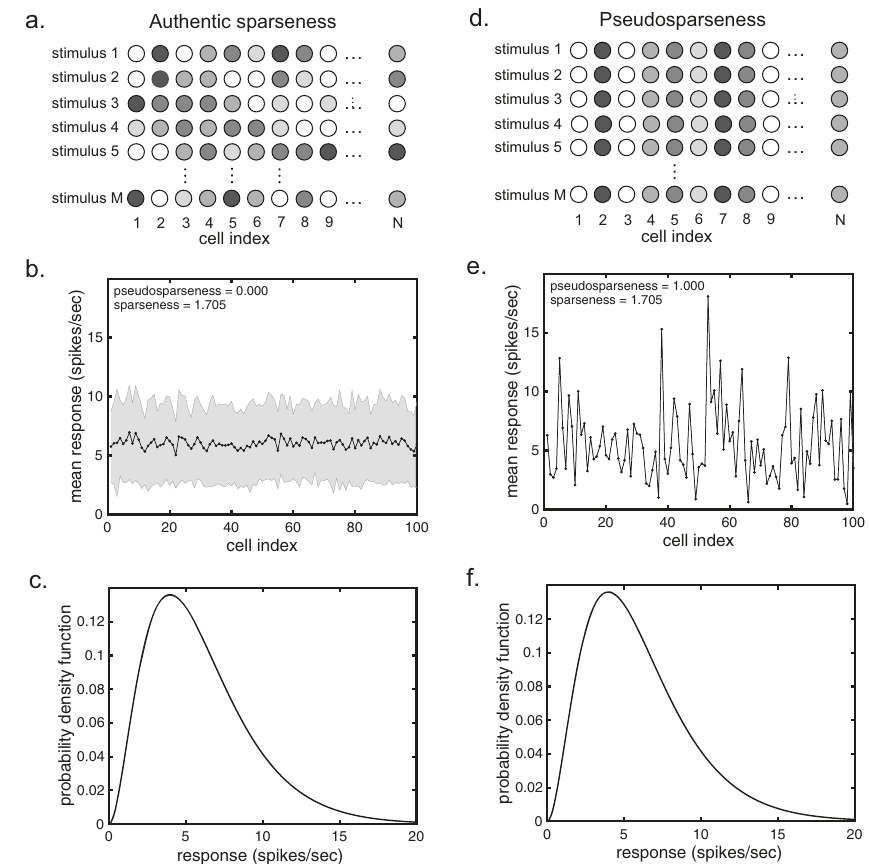
Fig. 1 Comparison between sparseness and pseudosparseness. a – c Example showing authentic sparseness. a Responses of the same neural population to different stimuli, under authentic sparseness. Each row of circles shows the responses to a different stimulus, with gray levels indicating response levels. Population responses to different stimuli are uncorrelated and a different random set of neurons is activated by each stimulus. b An example population response spectrum for authentic sparseness. Mean stimulus response (black) and response standard deviation (gray shading) for each neuron in the population is plotted on the y -axis, with neurons assigned arbitrary index numbers along the x -axis. For this example, each stimulus produces a set of responses across the population described by a gamma distribution. Parameters for the gamma distribution are identical for each member of the stimulus set. The pseudosparseness index calculates the mean correlation coef fi cient between population response vectors between all members of the stimulus set. c Median probability density function (pdf) for the neural population responses for individual stimuli under authentic sparseness. Each stimulus produces a single pdf for the responses across the neural population, and then the median pdf from all stimuli is determined and shown. d – f Example showing pseudosparseness. d Responses of the same neural population to different stimuli, under pseudosparseness. Under pseudosparseness, population response vectors for different stimuli are correlated, so that the same set of neurons is always activated for all stimuli. e An example population response spectrum for pseudosparseness. The population spectrum is produced using the same gamma distribution for population responses as used for authentic sparseness. For pseudosparseness, however, population response vectors for different stimuli are perfectly correlated. Therefore, the population spectrum has a standard deviation of zero, and pseudosparseness = 1.0. f Median probability density function for individual stimulus responses under maximum pseudosparseness. Note that this probability density function is identical to that under authentic sparseness in c . In the plots for the model N = 100 neurons with n = 10,000 stimuli per